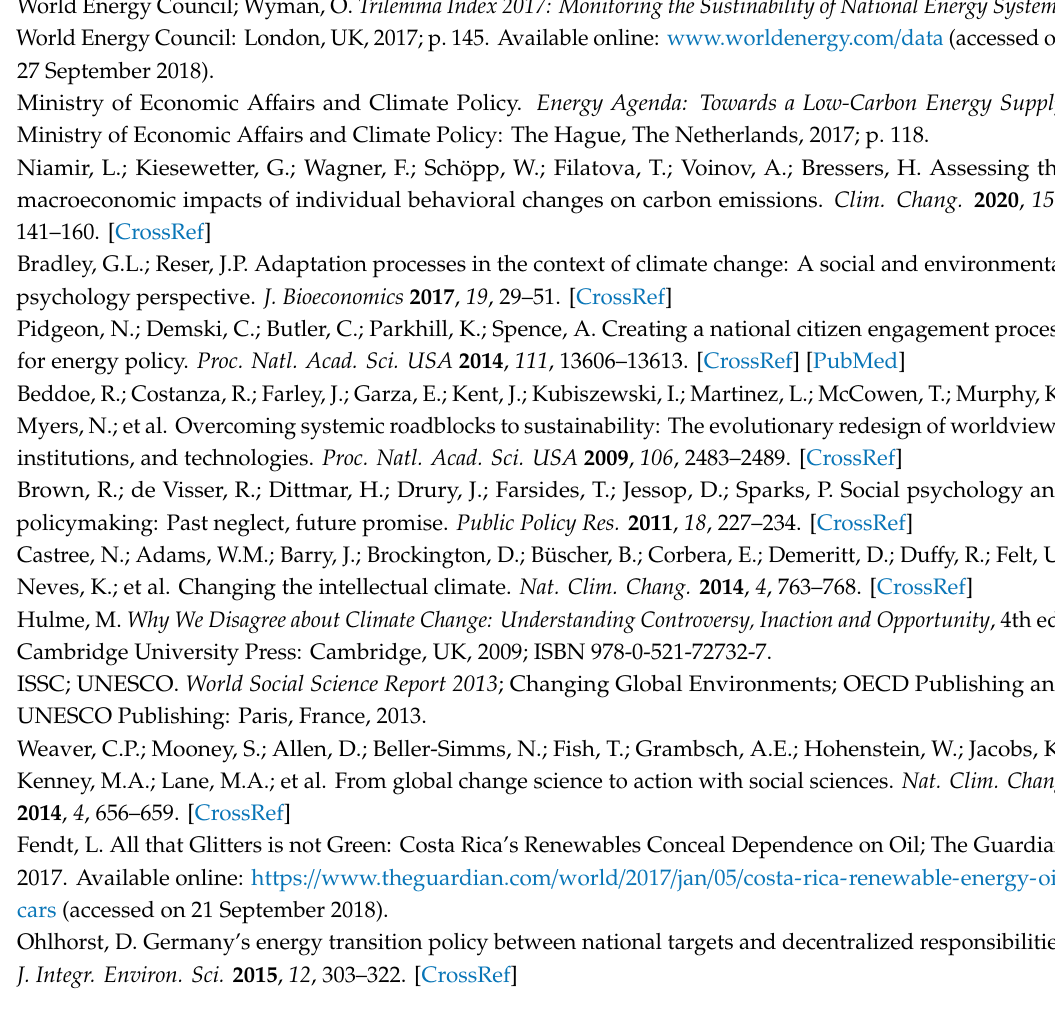
Table S1. Subcategories indicators based on social impacts targeting organizations and individuals shown in Table 2. Table S2. Social performance based on scoring scheme of Figure 2 of the Dutch energy sector with developed S-LCA hotspot indicators, detailed version of Table